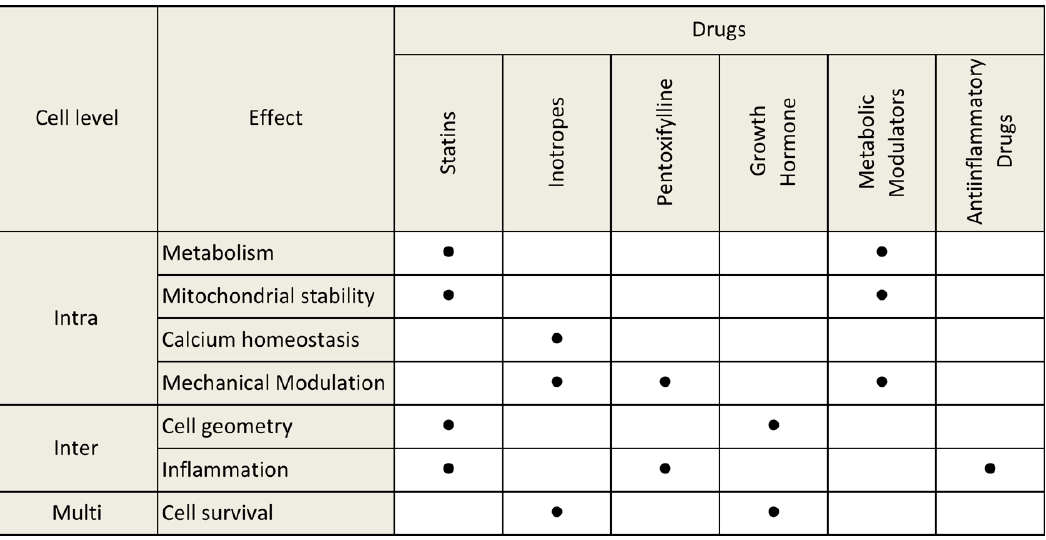
Figure 4. Summary of pleiotropic and overlapping effects of drug classes towards putative pathologic driving mechanisms of iDCM.